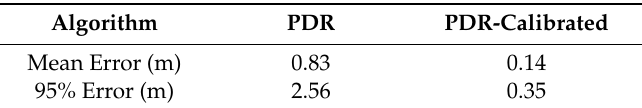
Table 3. Statistics of positioning errors.